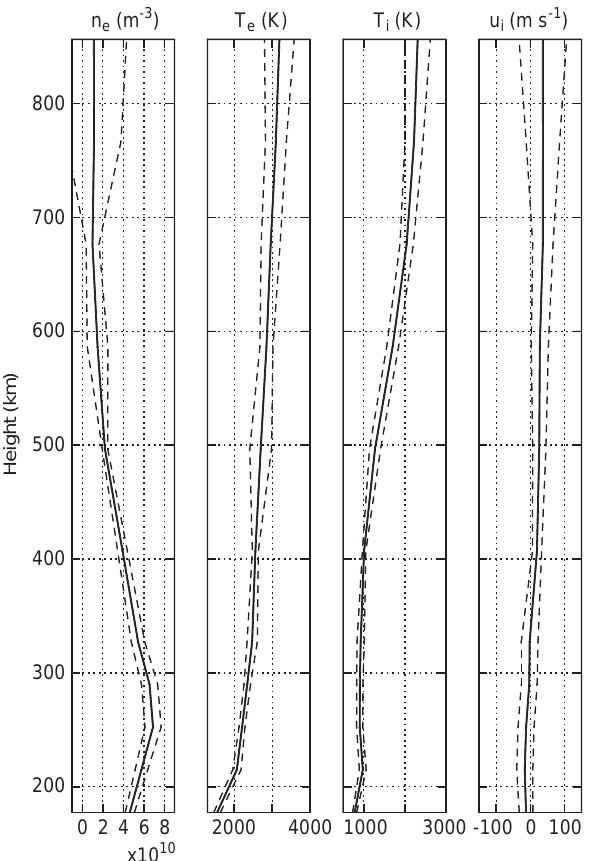
Fig. 1. The electron density n e , the electron and ion line temperatures T e and T i and ion mean drift velocity u i as a function of altitude averaged over the 1-h period of the experiment run. The dashed lines represents the 1- r deviation from the averaged parameter ( solid line